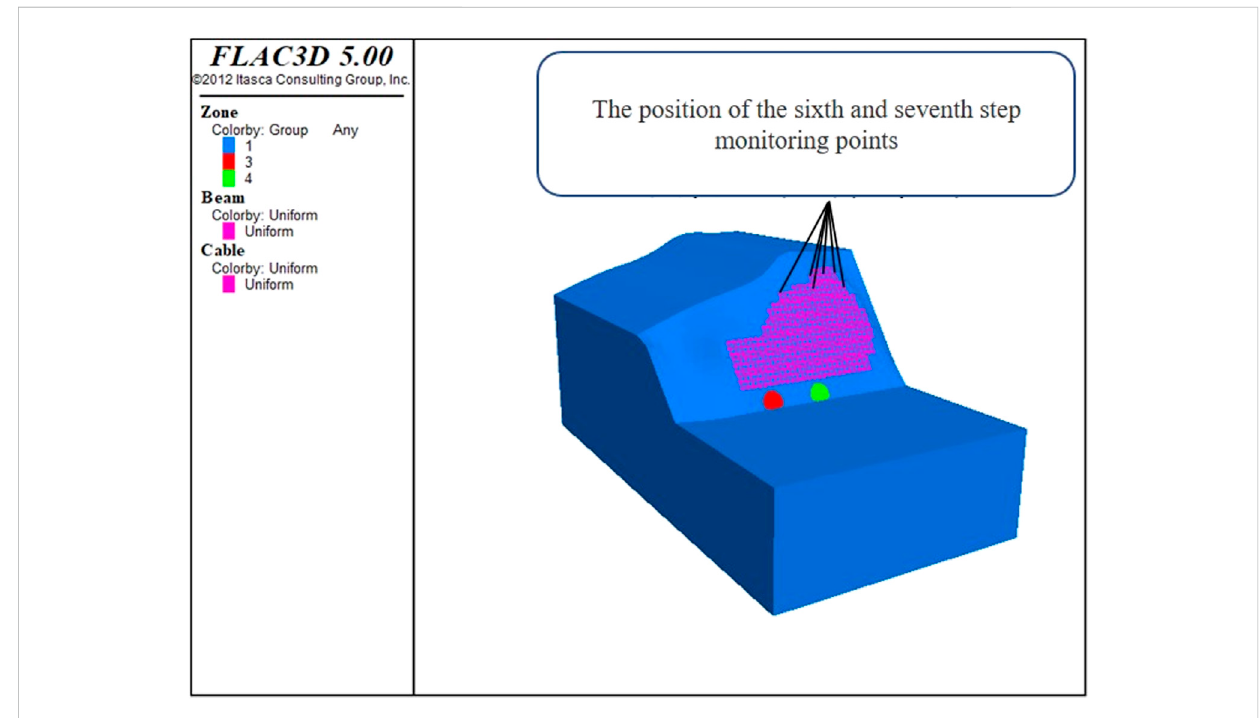
FIGURE 3 Layout schematics of monitoring points for sixth and seventh